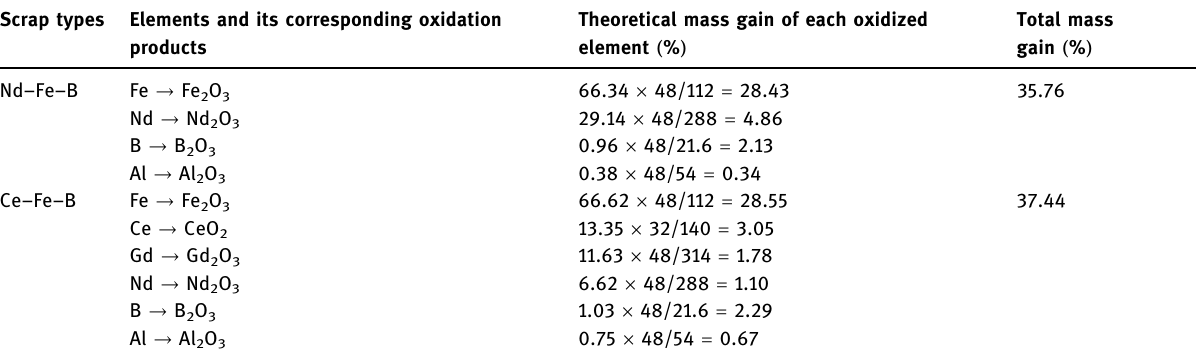
Table 2: Theoretical mass gain of each oxidized element and total mass gain of Nd – Fe – B and Ce – Fe – B magnet scrap powder Scrap types Elements and its corresponding oxidation products